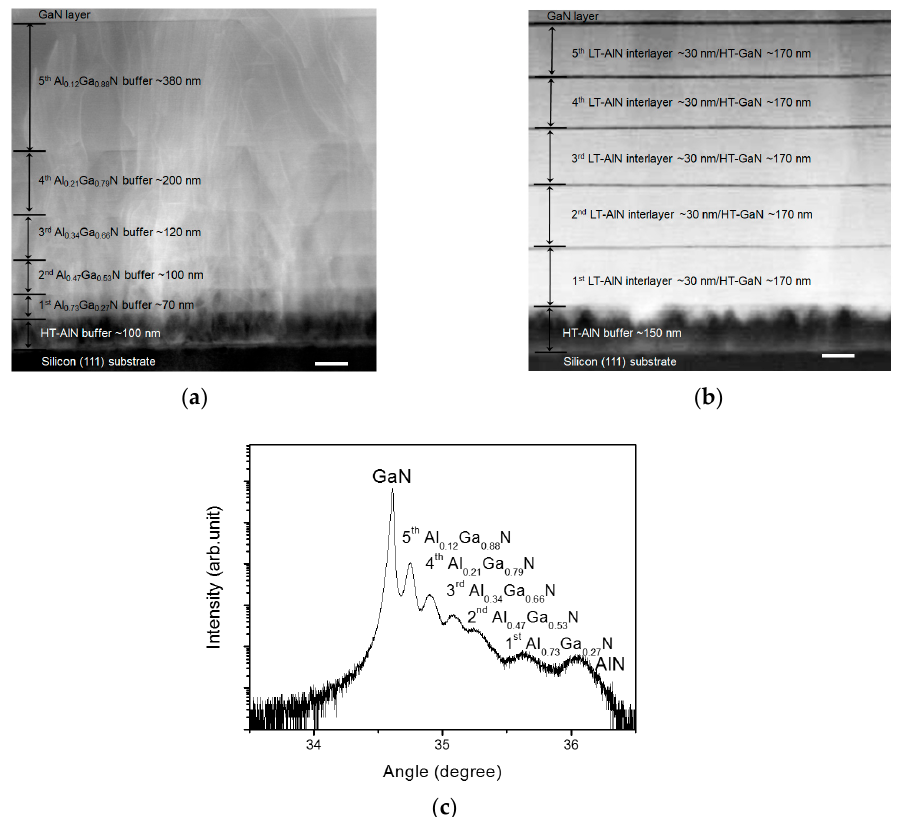
Figure 2. Transmission electron microscope (TEM) images of GaN epitaxial layer structures with different buffer layers. ( a ) Epitaxial layer structure with a step-graded Al x Ga 1 − x N buffer layer and ( b ) epitaxial layer structure with a conventionally-used HT-GaN/LT-AlN buffer layer (scale bar: 100 nm); ( c ) high-resolution X-ray diffraction (HR-XRD) 2 θ − ω scan of the GaN epitaxial layer grown on silicon substrate with the step-graded Al x Ga 1 − x N buffer layer, showing the Al mole fractions of the buffer